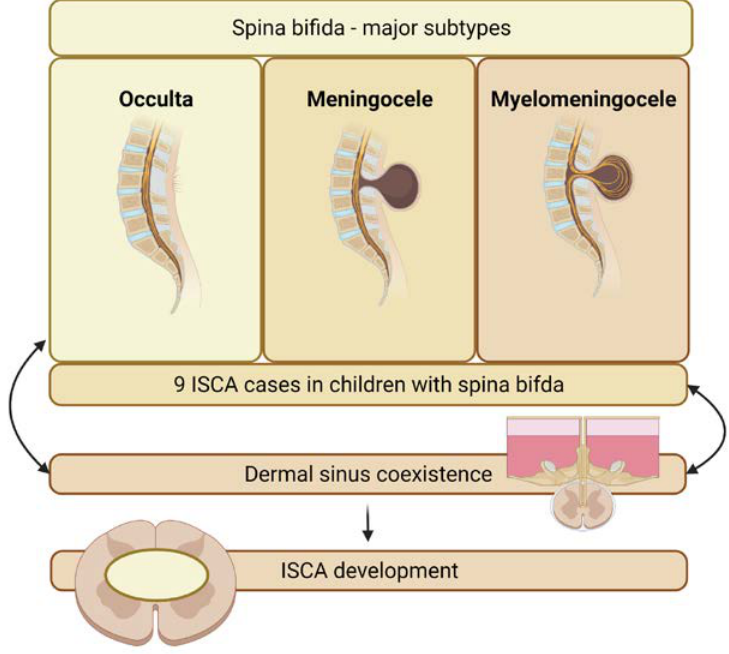
Figure 6. Relationship between spina bifida and intramedullary spinal cord abscess.